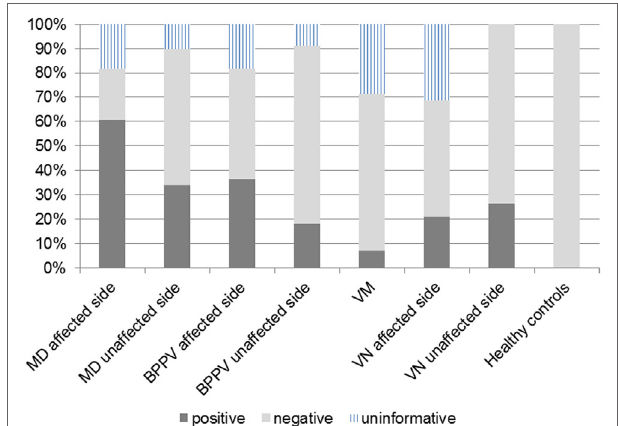
FigUre 3 | Positivity rate (Pr) in each group . The cutoff point of 500–1,000 Hz cervical vestibular-evoked myogenic potential slope was − 19.9. Definite Ménière’s disease (MD)-affected ears showed the highest PR.